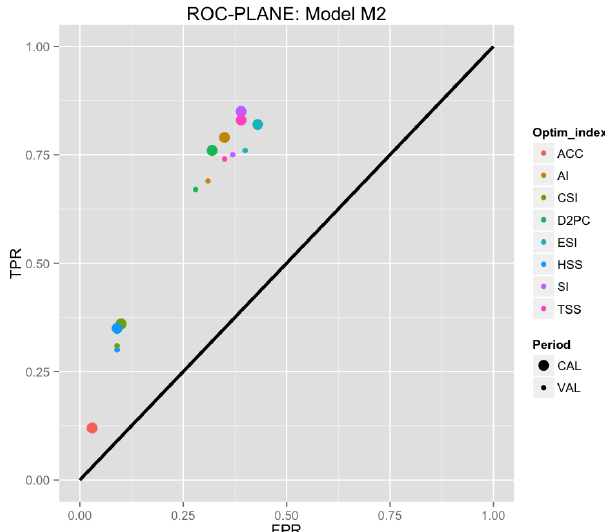
Figure B2. Models’ performance results in the ROC plane for